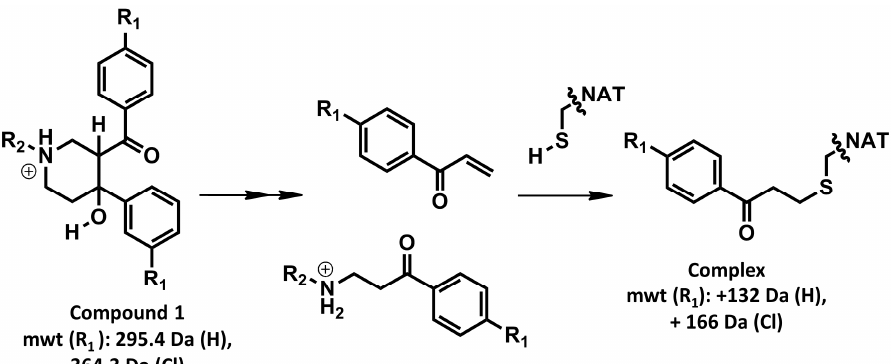
Figure 2. The mechanism of adduct